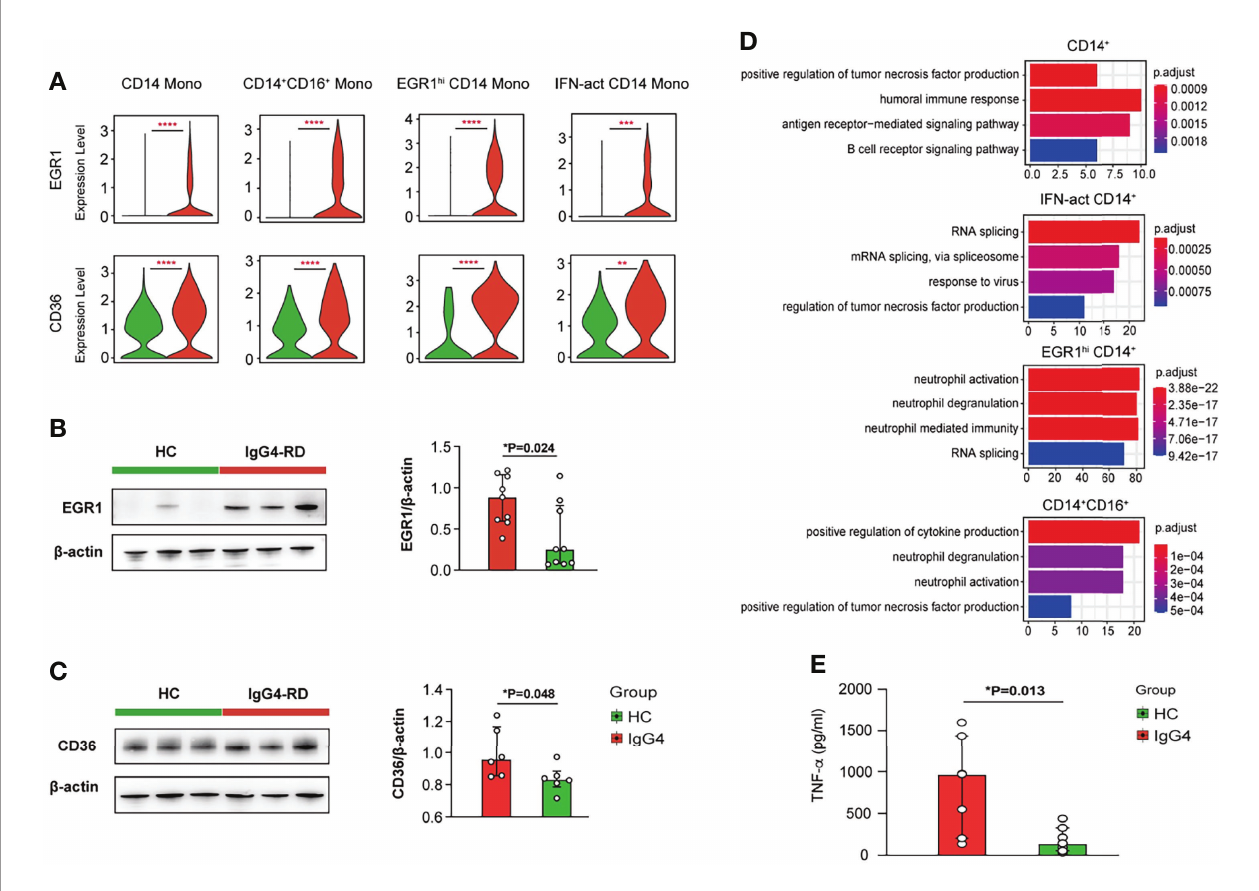
FIGURE 4 | Functional analysis of myeloid cells in IgG4-RD. (A) Violin plots showing expression of EGR1 and CD36 in different CD14 + mono subtypes. (B, C) The comparison of EGR1 and CD36 expressions in puri fi ed CD14 + monocytes from HCs and patients with IgG4-RD. (D) GO analysis showing the biological process enriched in different CD14 + monocytes of patients with IgG4-RD. (E) CD14 + monocytes puri fi ed from PBMCs of HCs and patients with IgG4-RD and cultured for 12 h in vitro . The TNF- a in the supernatant was measured using ELISA. Data are expressed as mean ± SD, *P < 0.05, **P < 0.01, ***P < 0.001, and ****P <